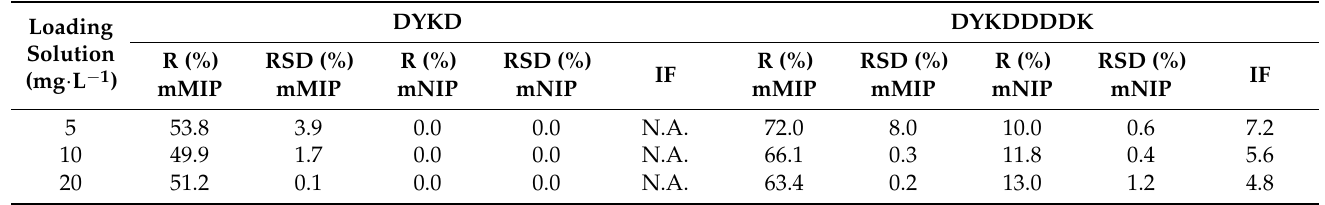
Table 4. Recovery rates (R, %), relative standard deviations (RSD, %) and imprinting factors (IF) of the peptides in the polymers synthesized in organic